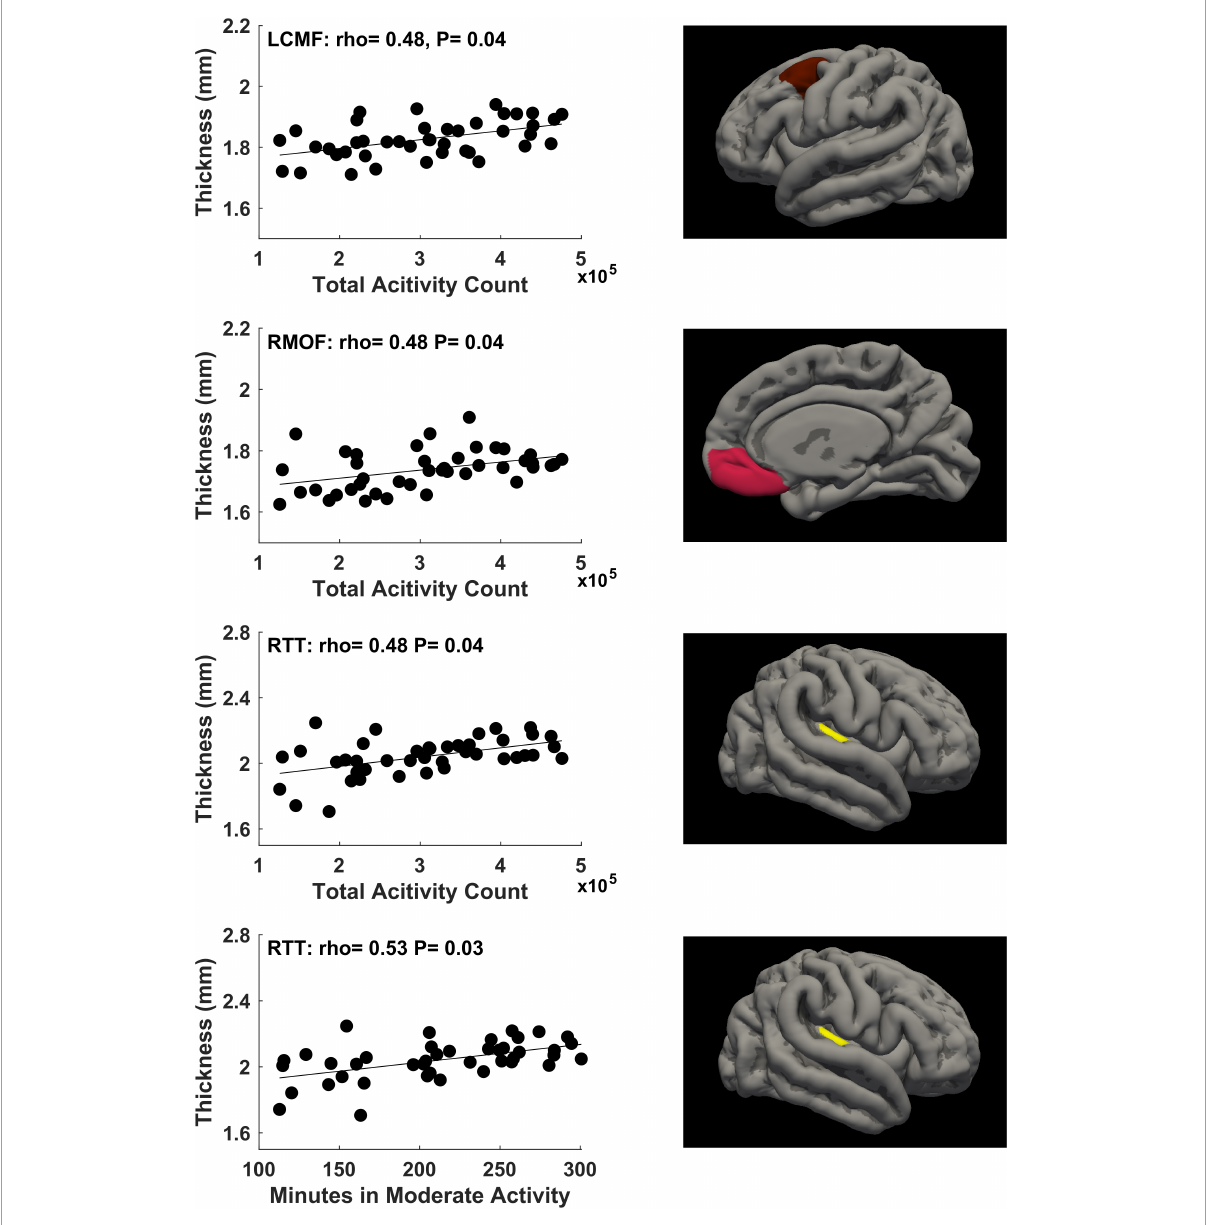
FIGURE2 Significant positive correlations ( P ≤ 0.05, FDR corrected) between mother’s physical activity at 4–10 weeks of pregnancy and newborn’s brain cortical thickness in the left caudal middle frontal (LCMF) gyrus, right medial orbital frontal (RMOF) gyrus, and right transverse temporal (RTT)